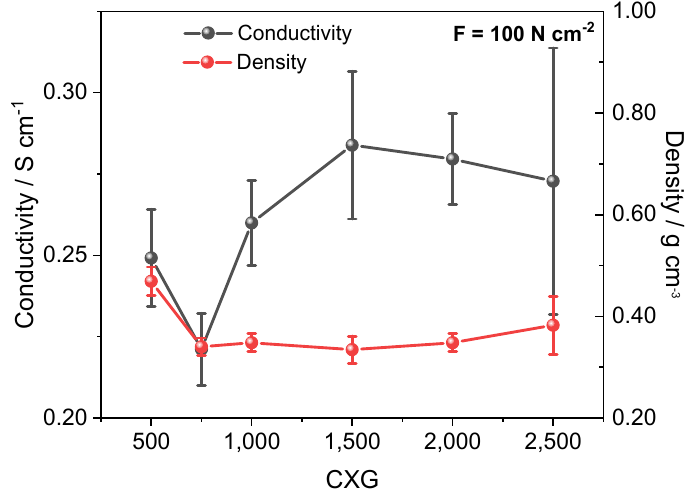
Figure 5. Conductivity and density values of CXG powders as a function of R/C ratio.